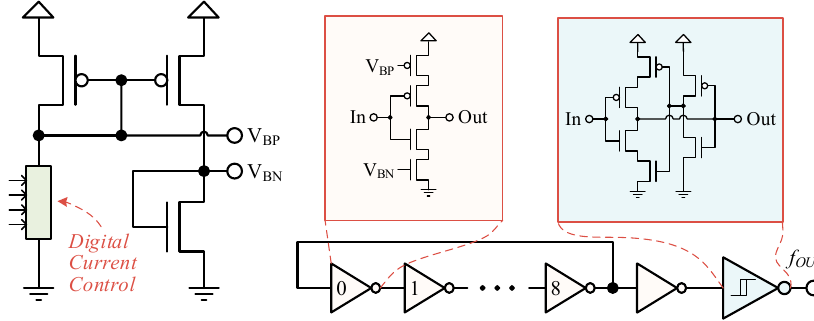
Figure 3. Ring oscillator with current starved inverters and biasing circuit.